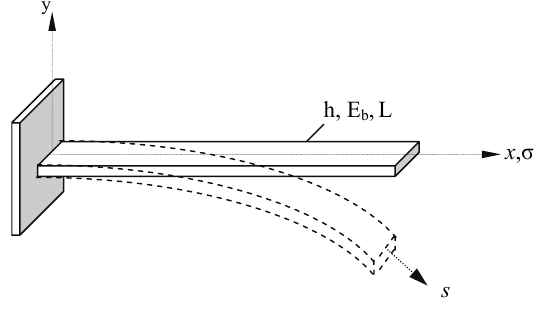
Fig.1. The geometry and boundary conditions of a beamshell. Figure 1. The geometry and boundary conditions of a